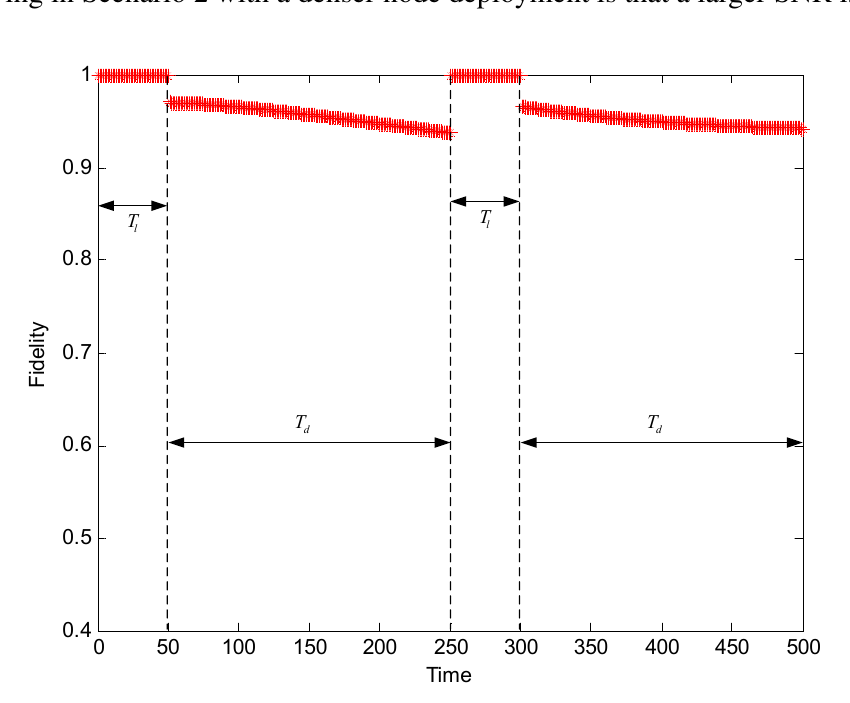
Figure 10. The changing fidelity for the scenario with 1000 nodes during the data